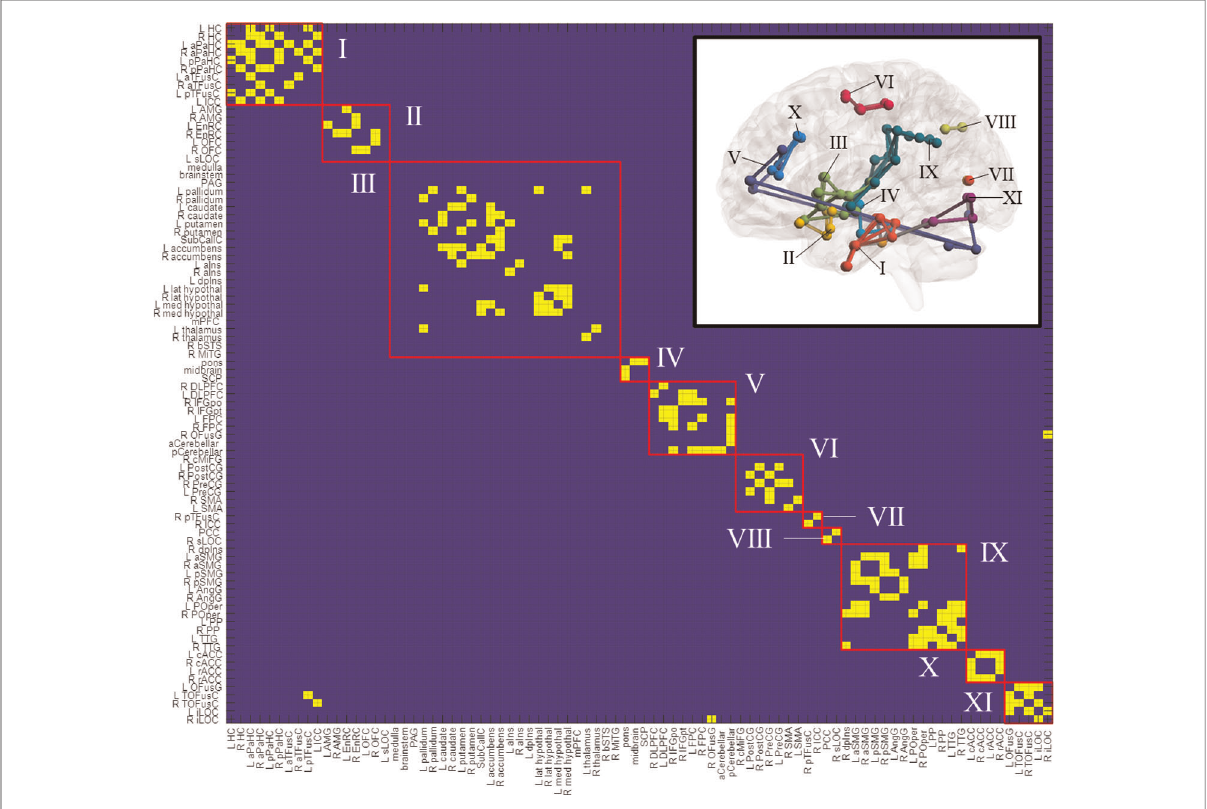
FIGURE 5 Nodal communities in the “ core ” network, as resolved with the louvain community detection algorithm. The core network is rendered in the fi gure inset. ROI abbreviations are de fi ned in Supplementary Table S1